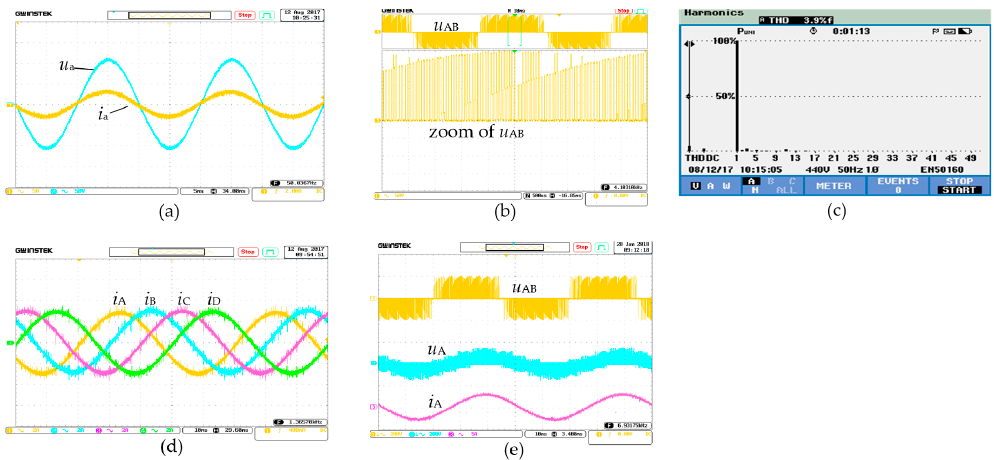
Figure 6. Experimental waveforms with U in = 80 Vrms, f out = 20 Hz, and q = 0.5: ( a ) input voltage u a and input current i a ; ( b ) output line ‐ to ‐ line voltage u AB and zoom of u AB ; ( c ) the FFT analysis of the u AB ; ( d ) output currents i A , i B , i C , i D ; ( e ) output line ‐ to ‐ line voltage u AB , output phase voltage u A , and